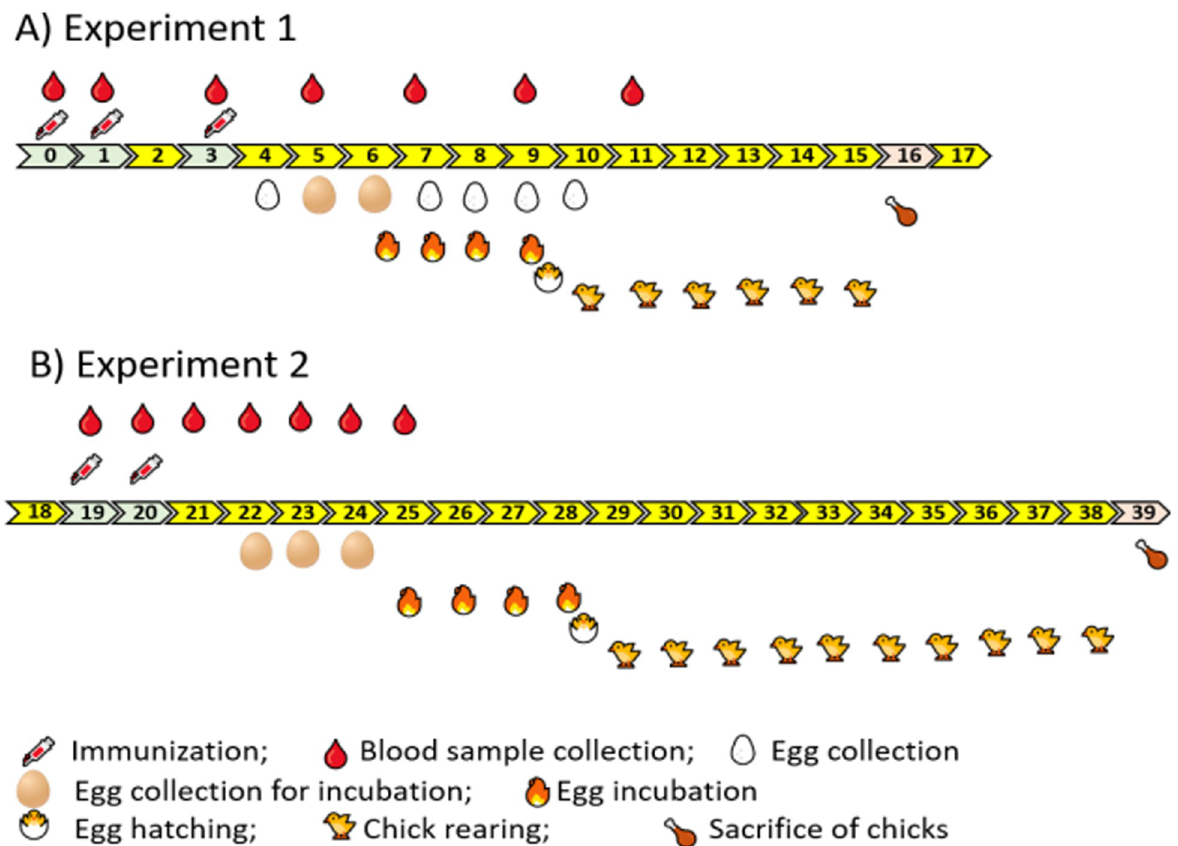
Fig 1. Animal experiment diagram from the first day of immunization. A) Experiment 1, B) Experiment 2. Numbers indicate weeks after the first immunization.